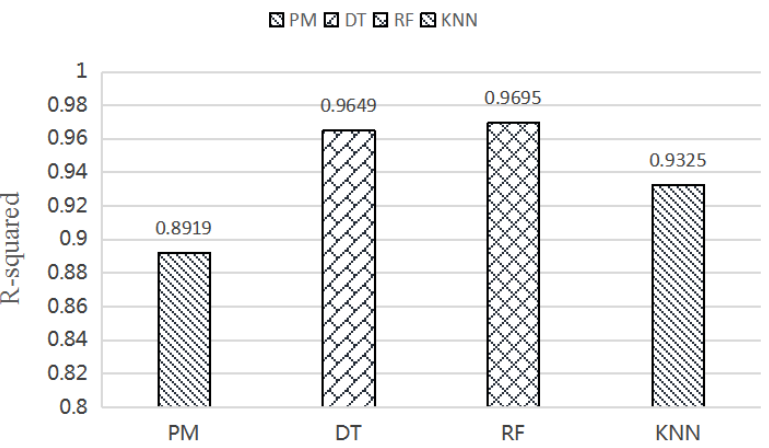
Figure 7. R-squared values of polynomial regression (PM), decision tree (DT), random forest (RF) and